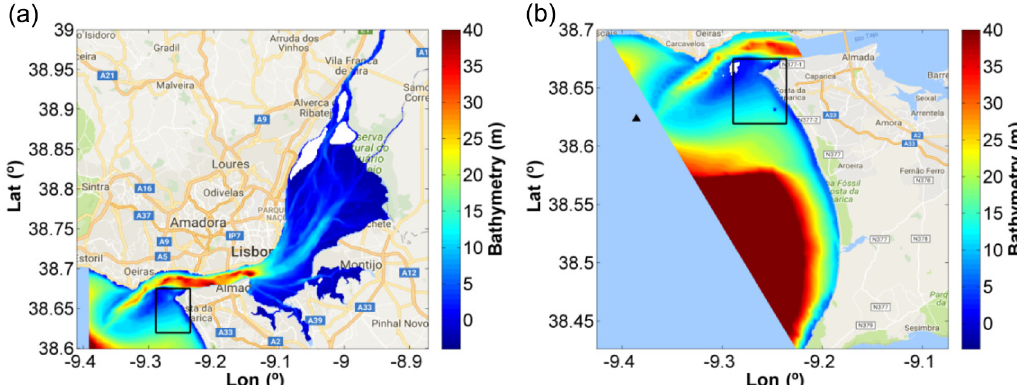
Figure 9. Bathymetries of the Tagus Estuary hydrodynamic model (a) and the wave model (b) created to propagate the waves until the Tagus Estuary mouth. The domain of the Costa da Caparica model is presented by the black rectangle and the location of the port of Lisbon wave buoy is indicated by the black